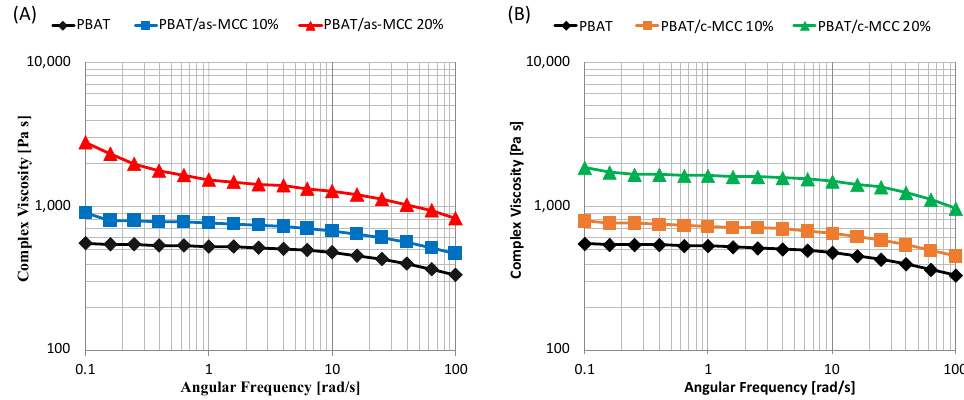
Figure 2. Complex viscosity as a function of frequency of ( A ) PBAT/as-MCC and ( B ) PBAT/c-MCC biocomposites.